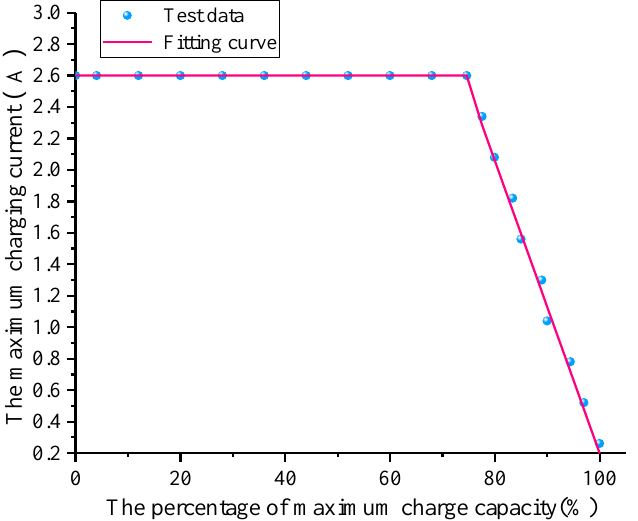
Figure 7. Relationship between the maximum charge capacity and its corresponding maximum charge current.